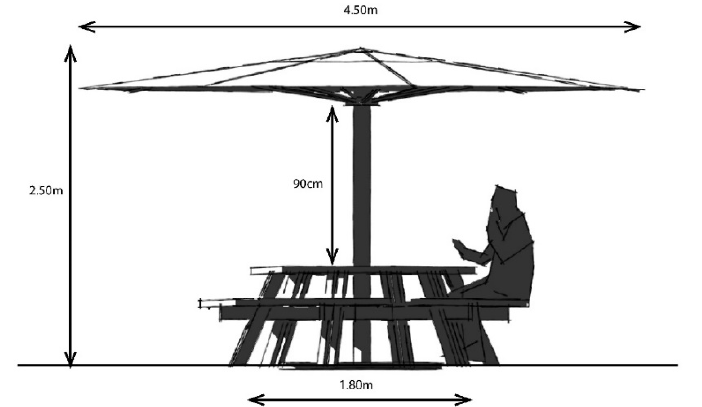
Figure 20. Dimensions of shade umbrella: umbrella diameter = 2.5 × diameter/diagonal length of table.